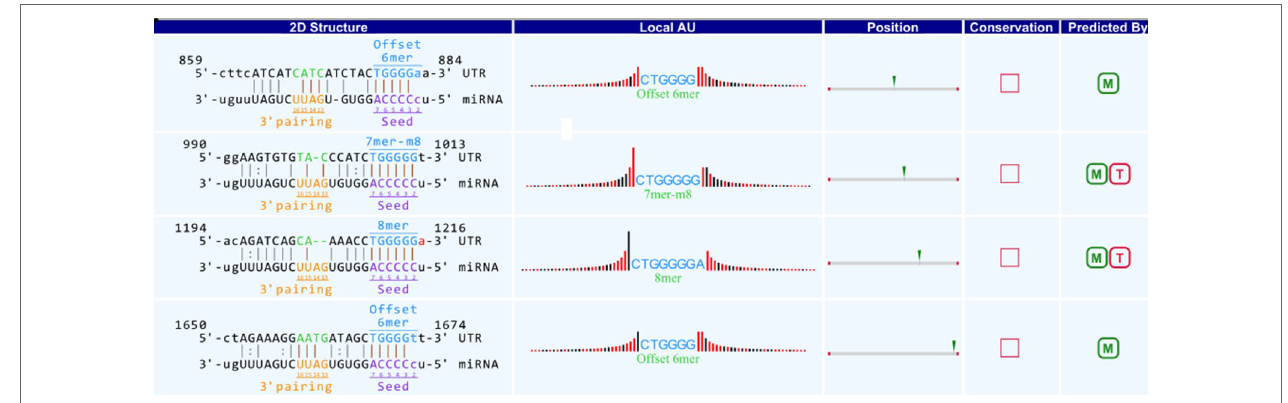
FIGURE 6 | Binding site of mmu_circRNA_013703 and mmu-miR-361-3p. The upper part is the sequence at the junction of circRNA and the lower part is the sequence of